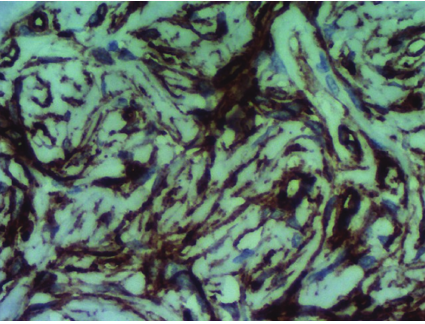
Figure 3: Immunohistochemistry of